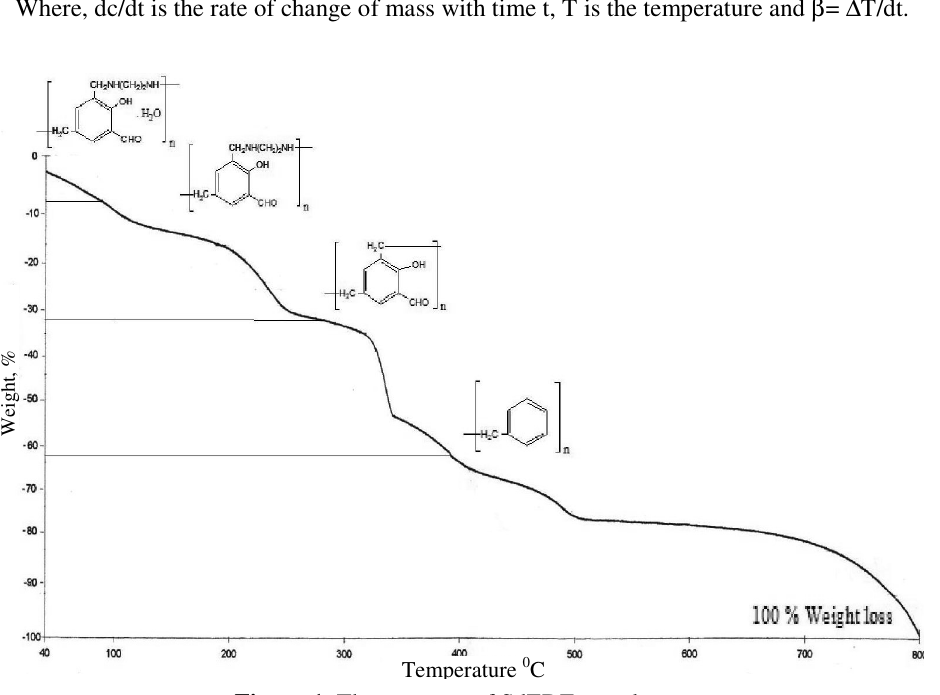
Figure 1. Thermogram of SdEDF